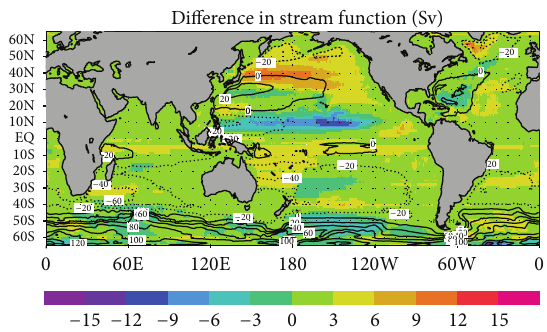
Figure 3: Difference in the mean barotropic volume transport function (in sverdrups) during 2001–2007 between the GY and CT cases (color) and mean value of barotropic volume transport function for the CT case